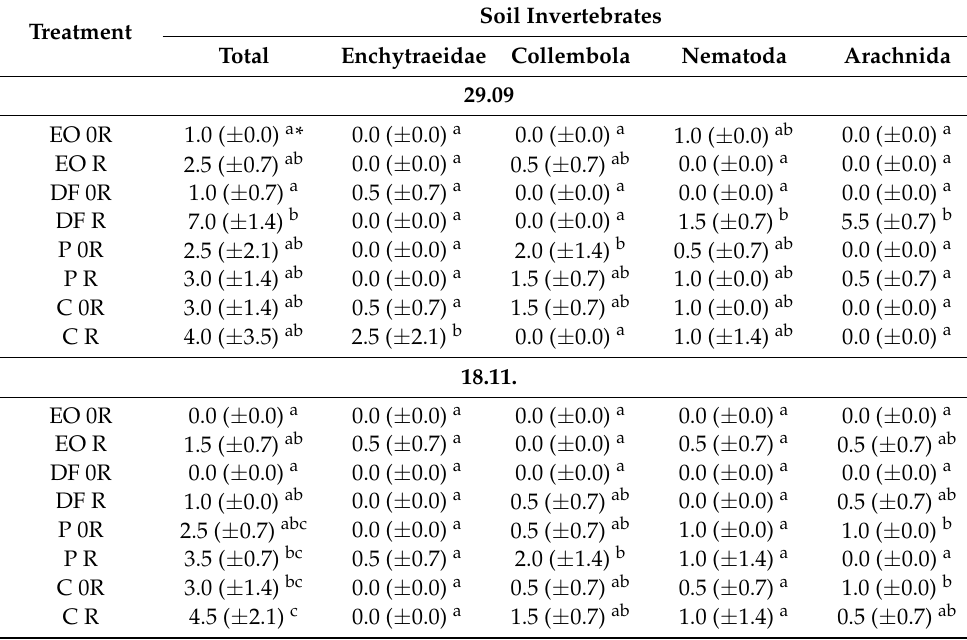
Table 2. The occurrence of soil invertebrates after four years from soil contamination and the use of ZB-01 (pcs. sample − 1